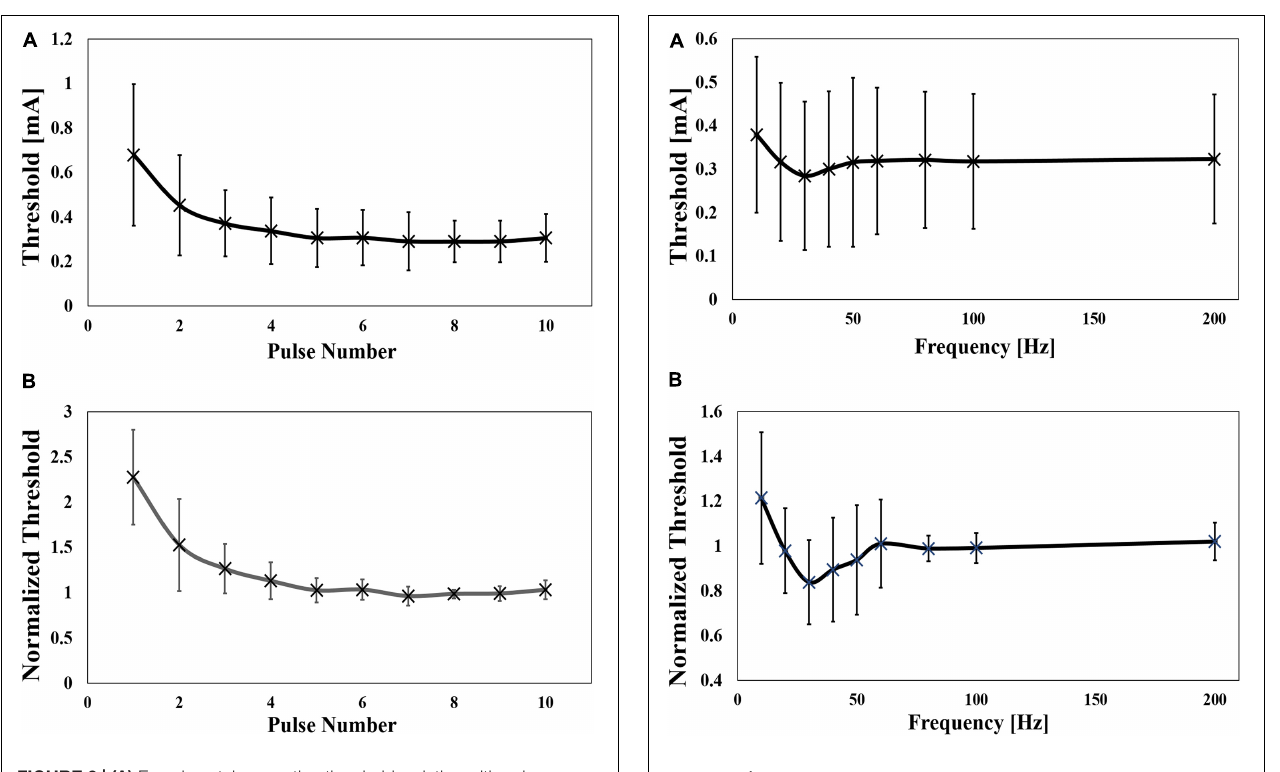
FIGURE 4 | (A) Experimental perception threshold variation with frequency by a pulse-train electrical stimulation (mean value and standard deviation, n = 9), and (B) its normalization by the average of the thresholds between 80 Hz and 200 Hz (mean value and standard deviation) (Mean value and standard